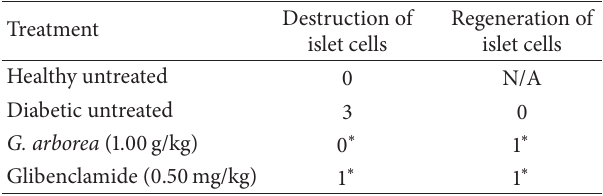
Table 3: Semiquantitative analysis of pancreatic tissue on selected parameters in streptozotocin induced diabetic rats after 30 days of plant